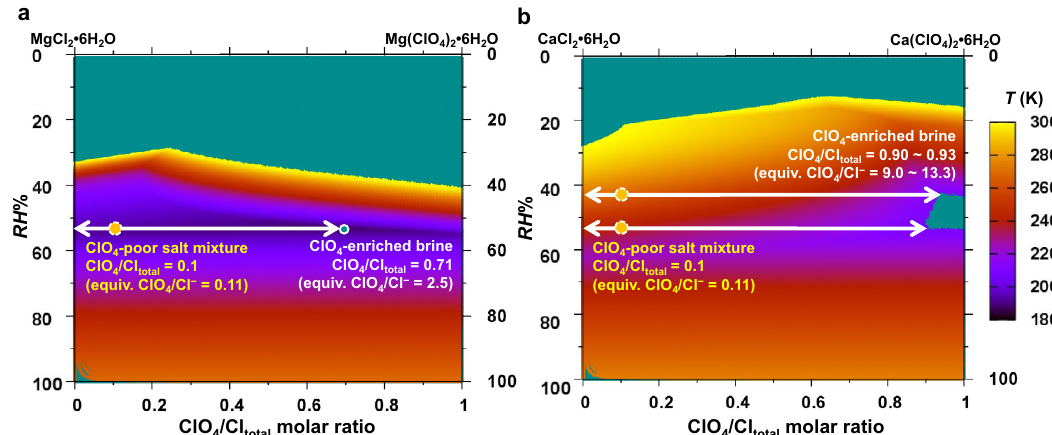
Fig. 3 Deliquescence-induced ClO 4 − /Cl − fractionation at the Phoenix landing site with Mg(ClO 4 ) 2 (cid:129) 6H 2 O + MgCl 2 (cid:129) 6H 2 O and Ca(ClO 4 ) 2 (cid:129) 6H 2 O + CaCl 2 (cid:129) 6H 2 O salt mixtures. a For the Mg(ClO 4 ) 2 (cid:129) 6H 2 O + MgCl 2 (cid:129) 6H 2 O salt mixture, the deliquescence surface (i.e., color surface represented by the legend) intersect with the RH -T conditions (i.e., cyan surface: the best fi t line of the scattered RH -T data in situ determined by Phoenix lander and independent of ClO 4 − / Cl total ) in a very small region (i.e., the cyan dot), with a ClO 4 − /Cl − molar ratio of 2.5. The RH is calculated based on RH% = 100 (cid:129) a w by the thermodynamic model. b For the Ca(ClO 4 ) 2 (cid:129) 6H 2 O + CaCl 2 (cid:129) 6H 2 O salt mixture, the deliquescence surface (i.e., color surface represented by the legend) intersect with the RH -T conditions (cyan surface) in a relatively large region (i.e., cyan trapezoid), with ClO 4 − /Cl − molar ratios ranging from 9.0 to 13.3. Starting with Mg- and Ca- salt mixtures that are initially poor in perchlorate (e.g., yellow dots as ClO 4 − /Cl − molar ratio = 0.11), deliquescence would simultaneously produce a nearly pure chloride salt (on the left arrow) and a ClO 4 − -rich brine (on the right arrow to the dark cyan intersection). The maximum ClO 4 − /Cl − molar ratios of deliquescence-induced brine are determined by the types of parent salt mixtures, regardless of the initial ClO 4 − /Cl − ratios in the salt mixtures. See Supplementary Fig. 16 for additional discussion on the ternary phase diagram and the